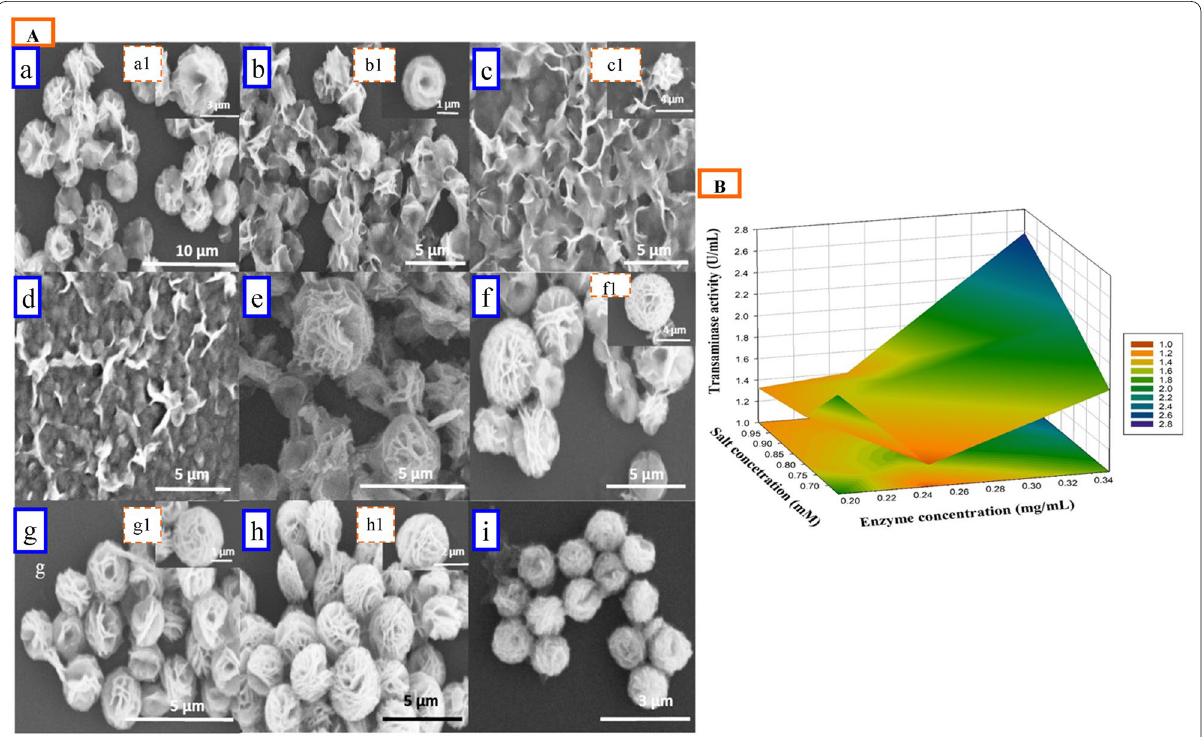
Fig. 3 A SEM images of hybrid nanoflower [TA@Cu 3 (PO 4 ) 2 NF] synthesis with various enzyme (mg/mL)/salt (mM) concentration, a 0.2/0.66, b 0.2/0.8, c 0.2/1.0, d 0.25/0.66, e 0.25/0.8, f 0.25/1.0, g 0.35/0.66, h 0.35/0.8, i 0.35/1.0, a 1 magnified image of a , b 1 magnified image b , c 1 magnified image of c , f 1 magnified image of f , g 1 magnified image of g , and h 1 magnified image of h. B TA activity of TA@Cu 3 (PO 4 ) 2 NF with different enzyme/ salt